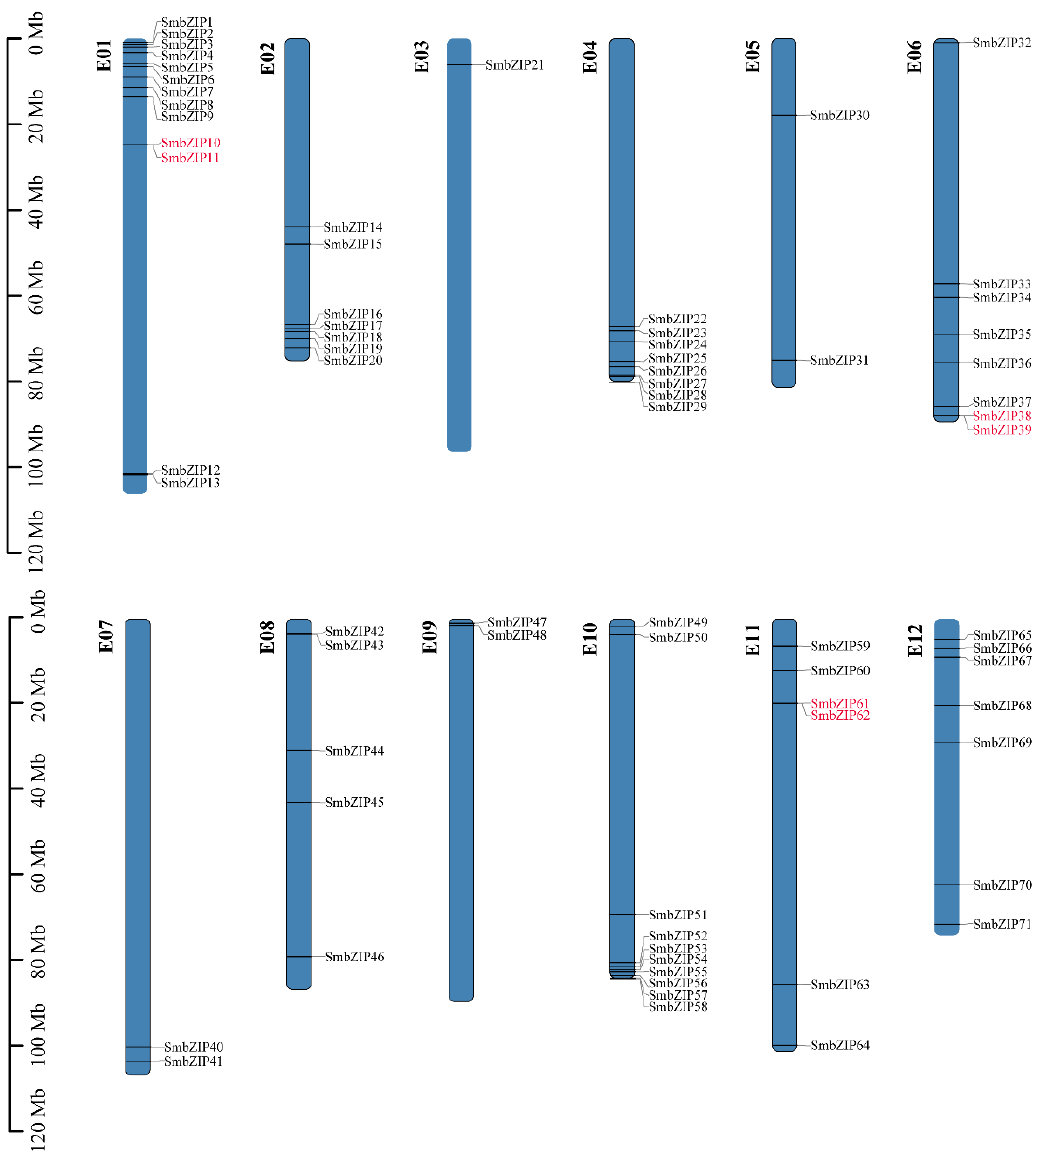
Figure 1. Distribution of SmbZIP genes on eggplant chromosomes. The relative length of a chro- mosome serves as a measure of its size. Red bars indicate tandemly duplicated genes.